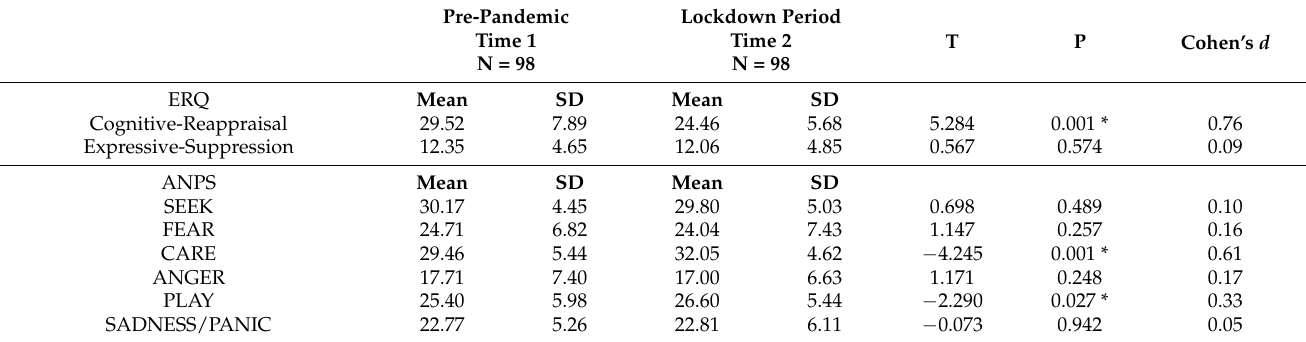
Table 1. t test comparison pre- and post-pandemic in ERQ and ANPS